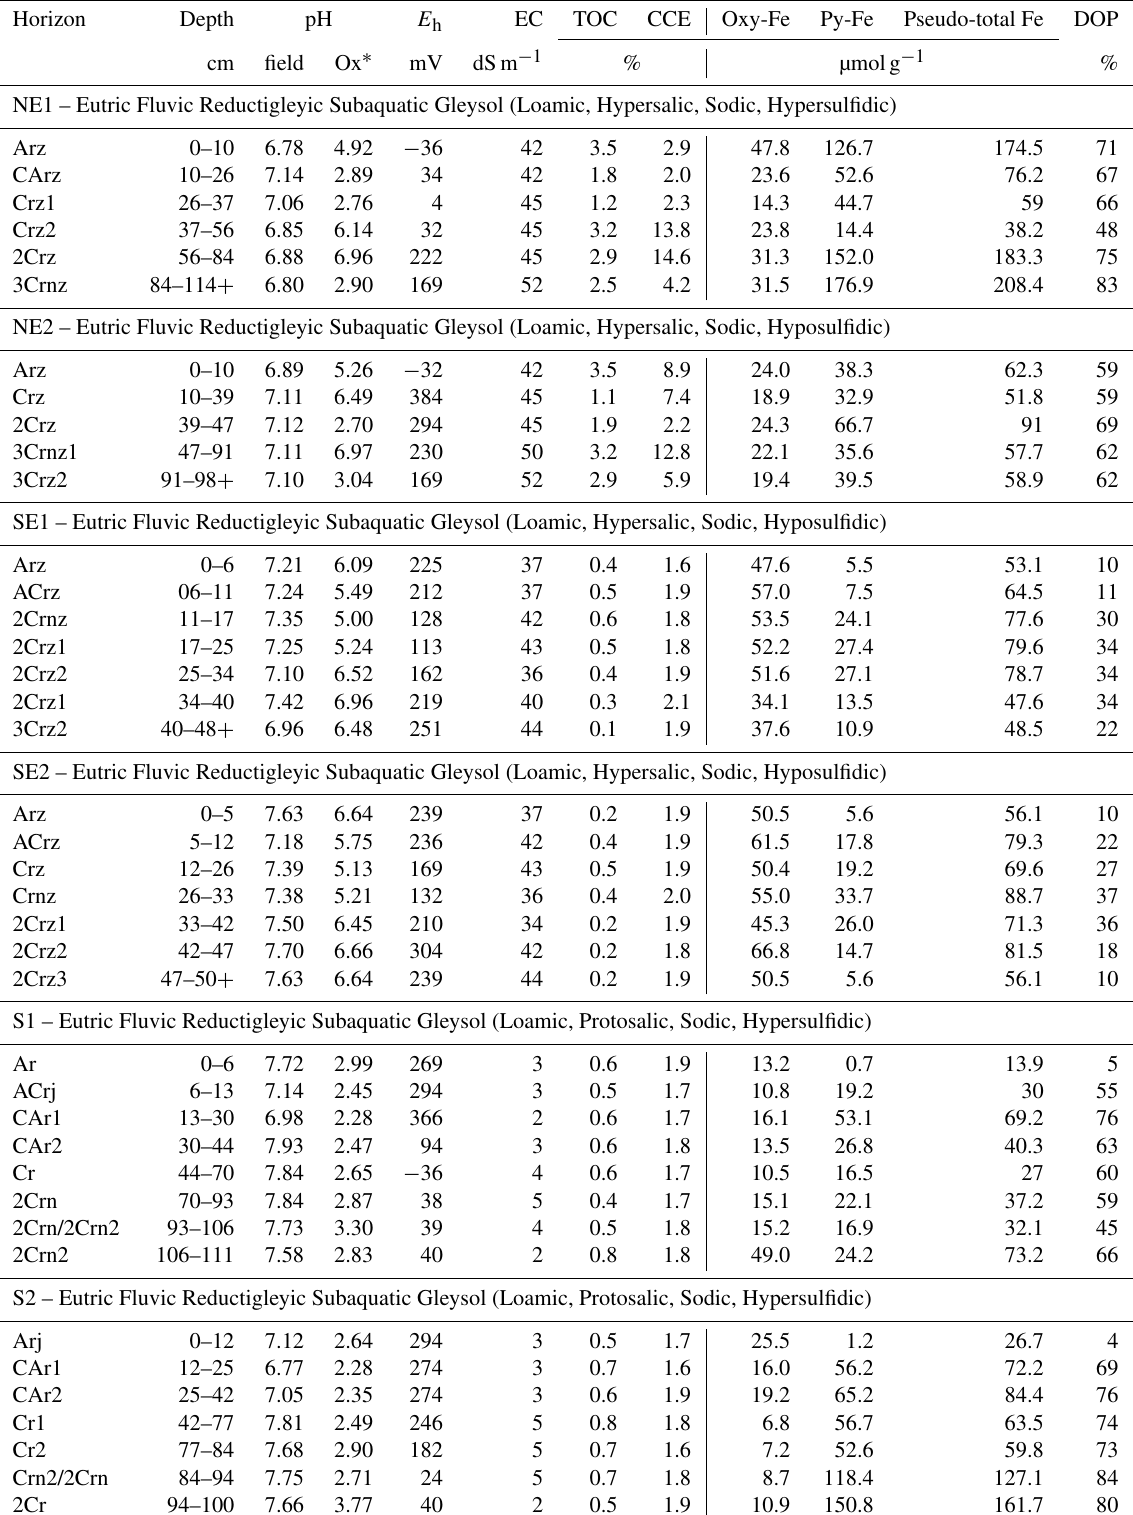
Table 2. Physicochemical conditions and Fe partitioning of seagrass meadow soils from the Brazilian coast.